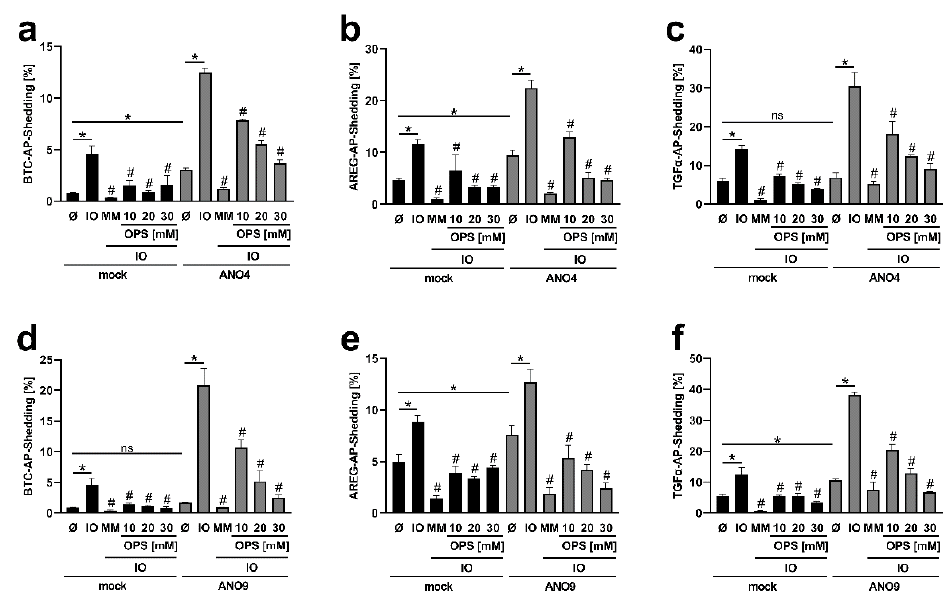
Figure 5. Release of BTC, AREG, and TGF α in ANO4- or ANO9-overexpressing cells depends on surface exposed phosphatidylserine. HEK293T cells were co-transfected with ANO4 ( a – c ) or ANO9 ( d – f ) vector (grey columns) or mock vector (black columns) and the AP-tagged ADAM10/17 sub- strates ( a , d ) BTC, ( b , e ) AREG, or ( c , f ) TGF α . Cells were stimulated with IO (1 µM) for 30 min in the absence or presence of inhibitors MM (10 µM) or OPS (10 mM, 20 mM, and 30 mM) and analyzed for the release of soluble BTC, AREG, or TGF α via AP-assay. * indicates a significant increase, # indicates a significant decrease compared to corresponding stimulated cells, and ns indicates no significant difference (n = 3; * p < 0.05; ± SEM). Data were analyzed by one-way ANOVA and Holm– Sidak multiple comparison post hoc test.